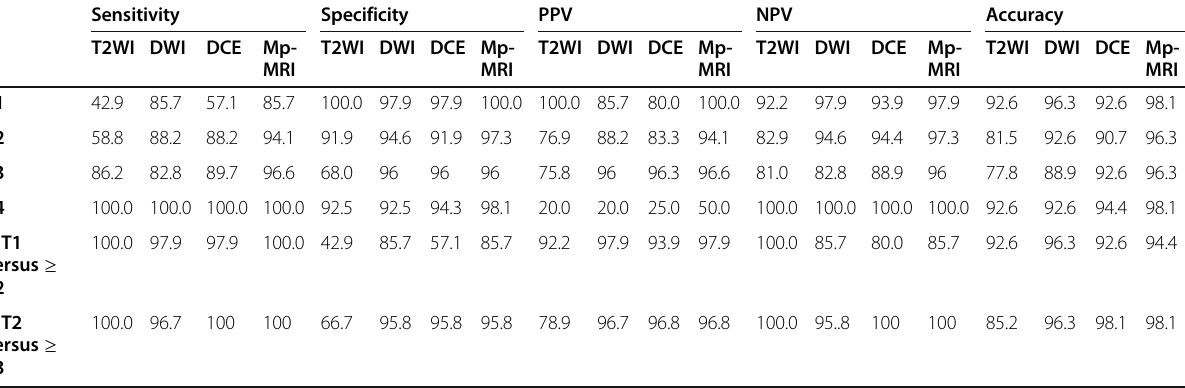
Table 2 Diagnostic performance of the different sequences and mp-MRI and their extent of agreement with pathological staging results